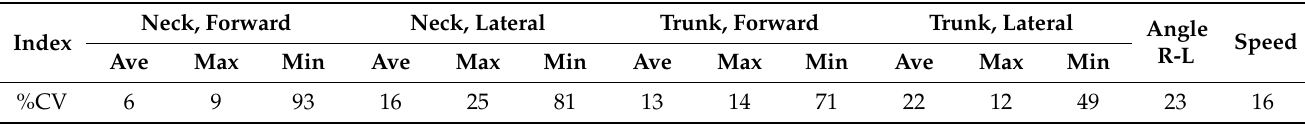
Table 2. Coefficient of variation (CV) values for different parameters ( n = 12).